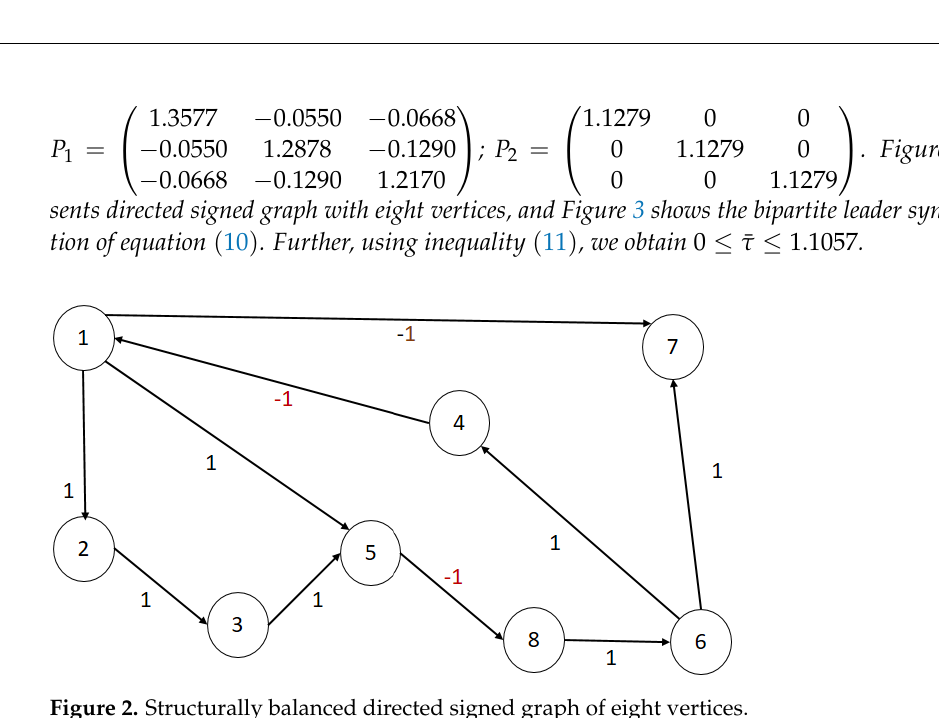
Figure 2. Structurally balanced directed signed graph of eight vertices.